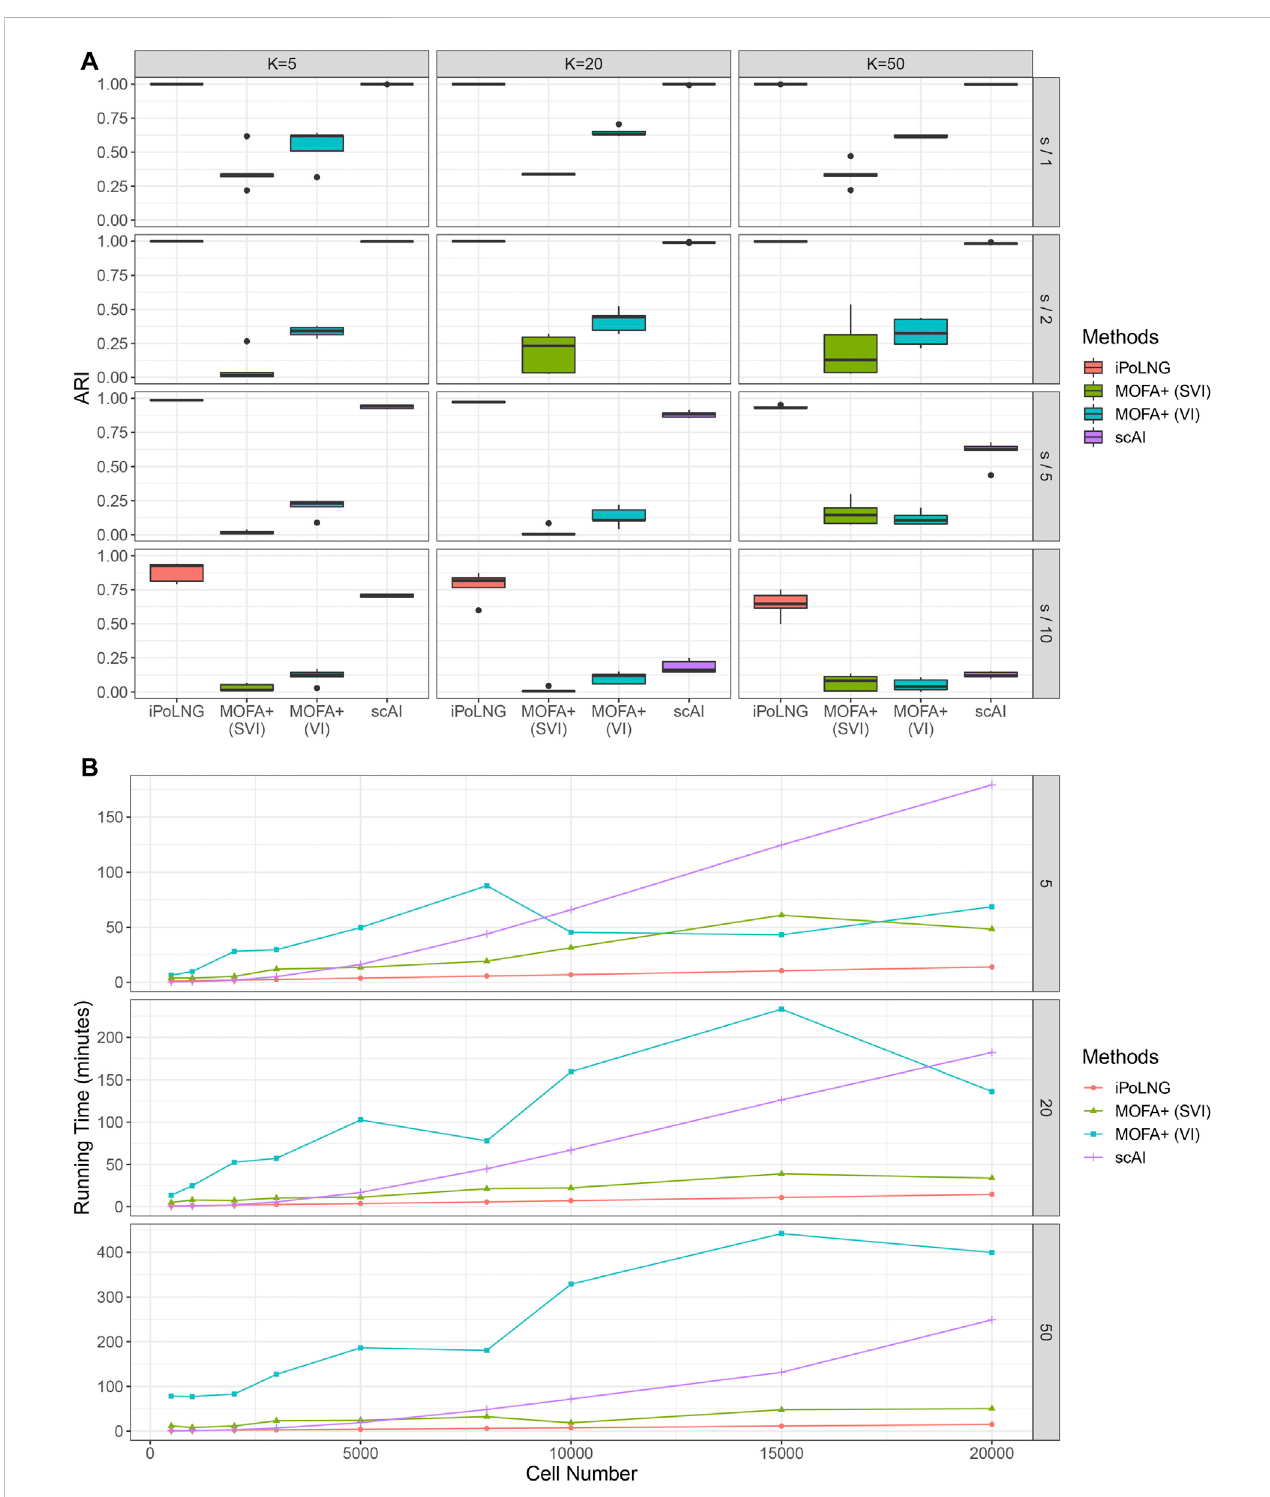
FIGURE 5 Comparison of clustering performance and running time for simulated data. (A) ARI scores for K = 5, 20, 50 and the level of noise is adjusted by dividing the sequencing depth by 1, 2, 5, and 10. The boxplot represents the ARI scores for 5 simulated datasets under the same setting. (B) Computational time for iPoLNG,MOFA+andscAI.MOFA+(VI)andscAIwererunonaserverwithIntelXeonGold6246RCPUand120 GBRAM.iPoLNGandMOFA+(SVI)wererunon a server with NVIDIA Tesla V100 GPU and 80 GB